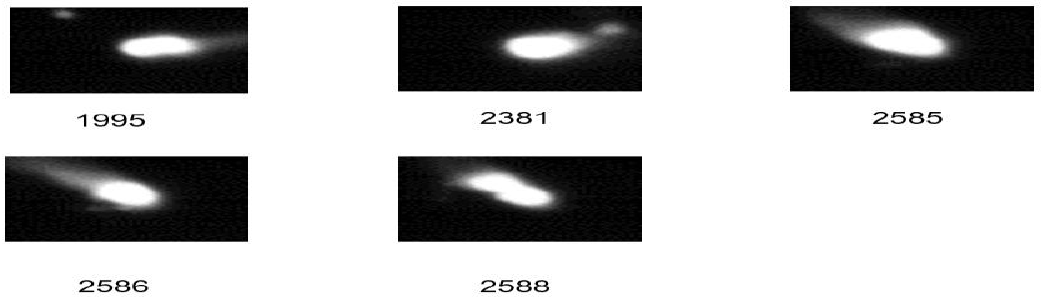
Figure 6. Defected melt-pool images.